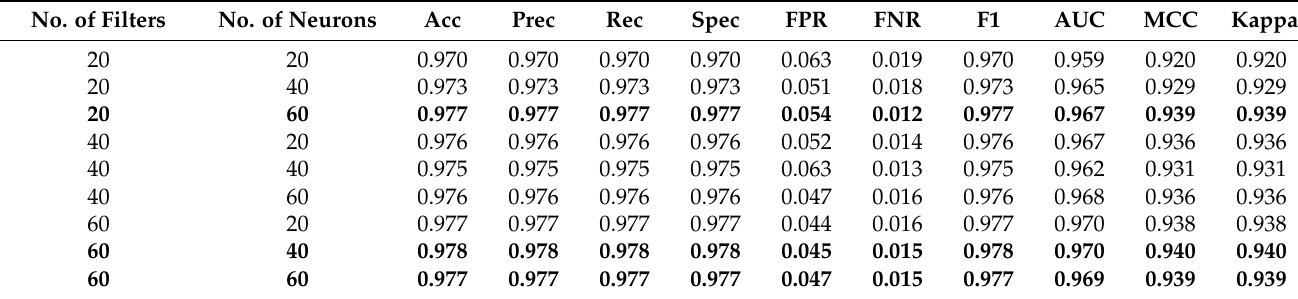
Table 6. Deep learning results with a different number of filters in convolutional layers and neurons in the final fully- connected layer of the 1D-CNN model. Best results are given in